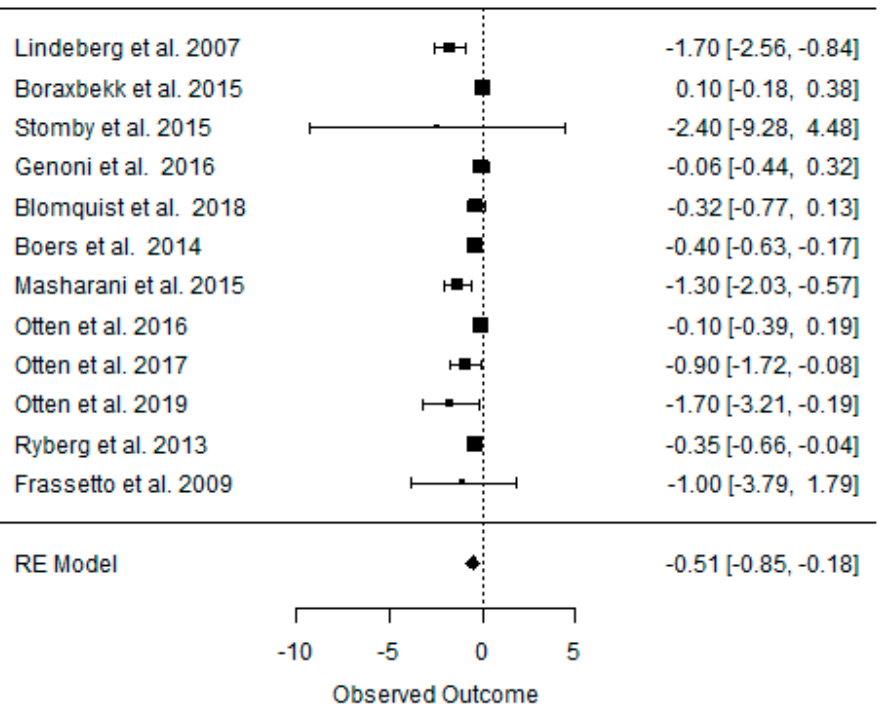
Figure A43. Forest plot of the effect of a CD on DBP in the long term (weighted mean difference).